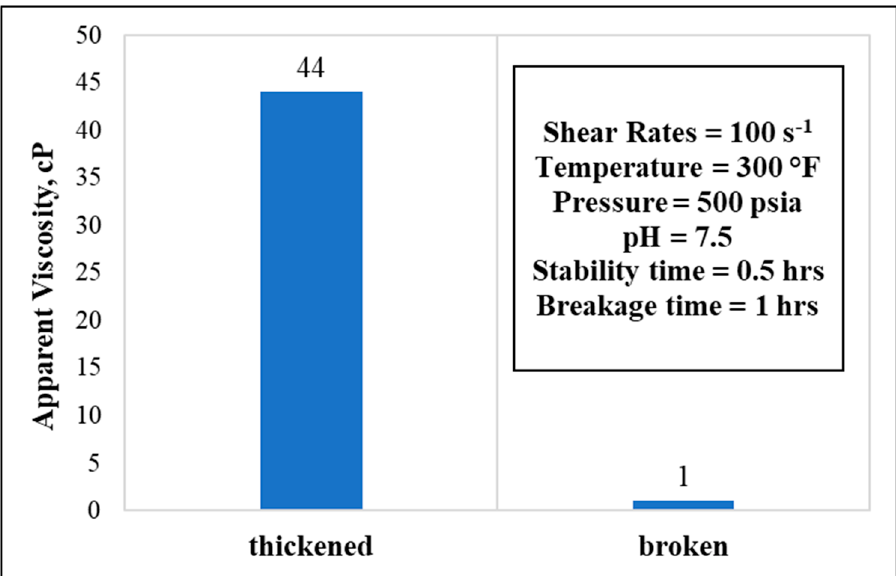
Figure 12. Thickening and breaking behaviors with respective parameters (polymer concentration = 50 pptg, GLDA concentration= 10 wt.%, water salinity = 70 k).